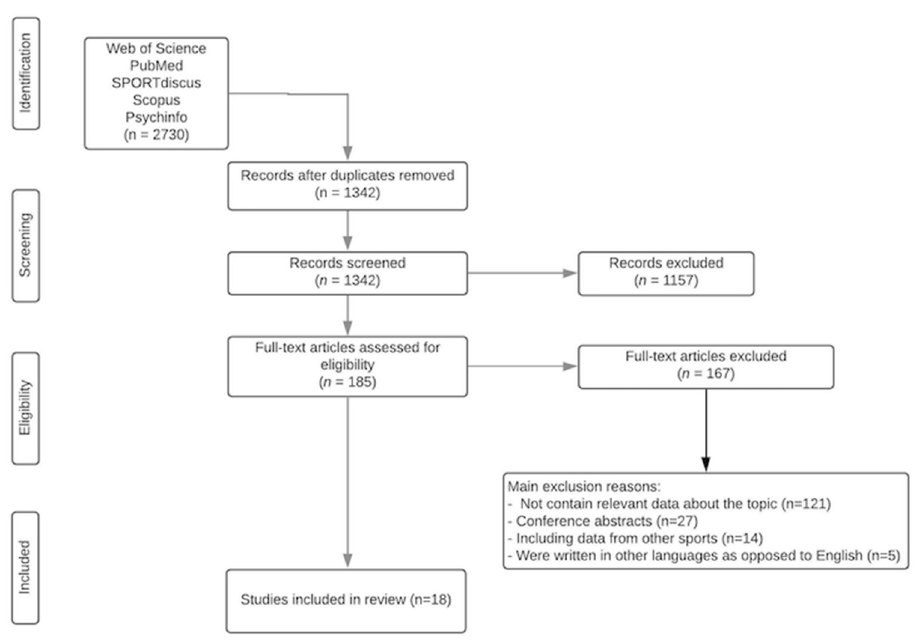
Figure 1. PRISMA flow diagram highlighting the selection process for the studies included in the current systematic review.